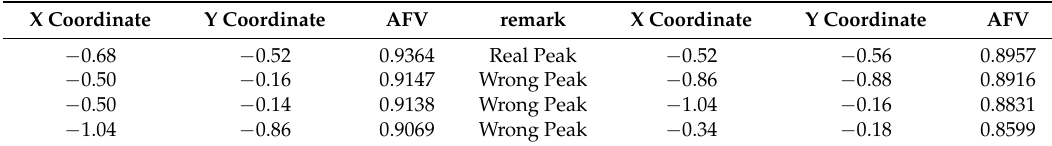
Table 4. The large AFVs of the dynamic experiment (static initialization